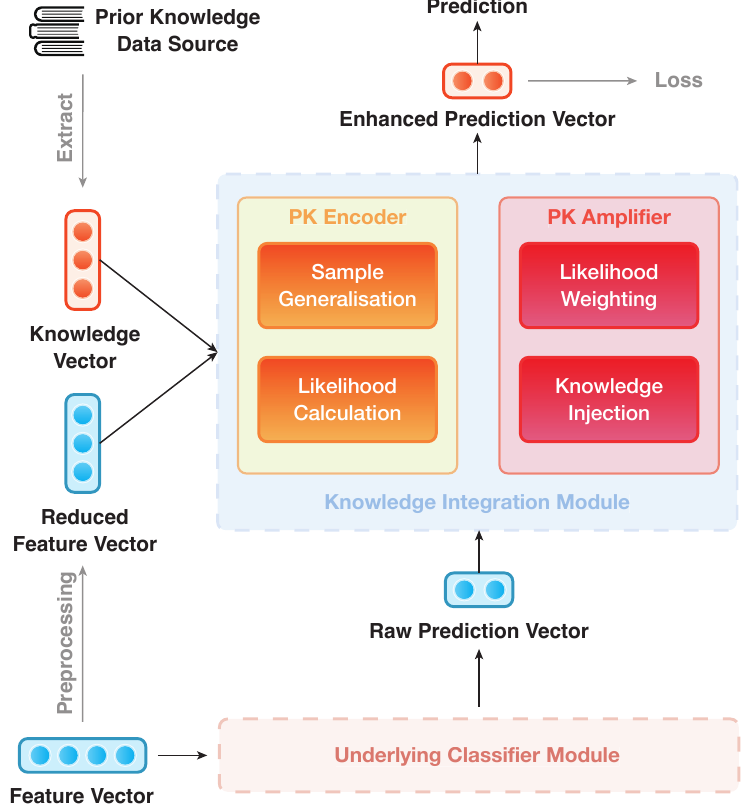
Figure 1. Overall structure of IAP.